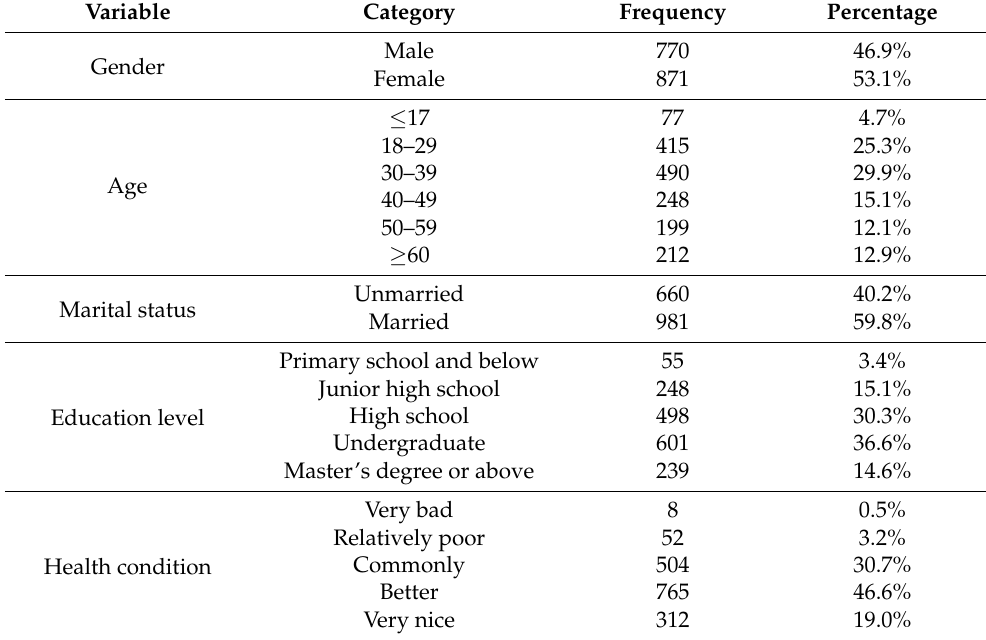
Table 2. Sample profile ( n =